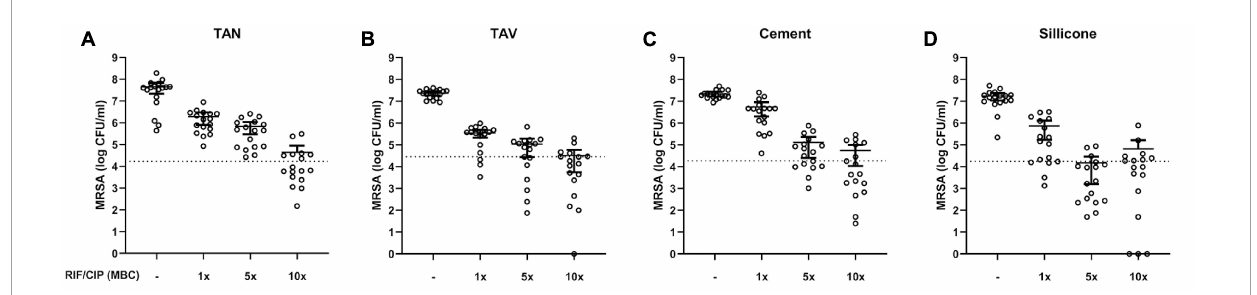
FIGURE3 Bacterial load (log CFU/mL) of mature 7-day MRSA biofilms adherent to various implant material disks: (A) titanium-aluminum-niobium (TAN); (B) titanium-aluminum-vanadium (TAV); (C) orthopedic bone cement and (D) silicone after 24 h exposure to 1-, 5- and 10-times the MBC of rifampicin (RIF) and ciprofloxacin (CIP). Results are shown as individual values ( N = 17), horizontal lines indicated means and error bars indicate 95% CI. The dotted line indicates 99.9% eradication threshold. CFU: colony forming units; MBC: minimal bactericidal concentration.